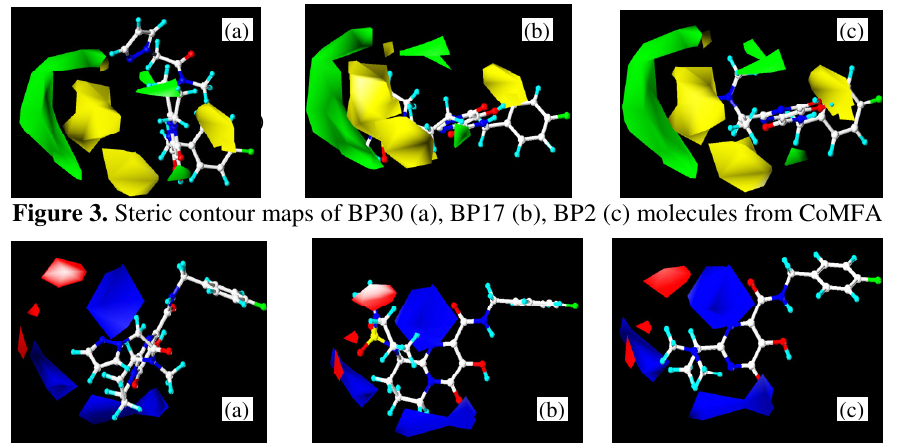
Figure 4. Electrostatic contour maps of BP30 (a), BP17 (b), BP2 (c) molecules from CoMFA